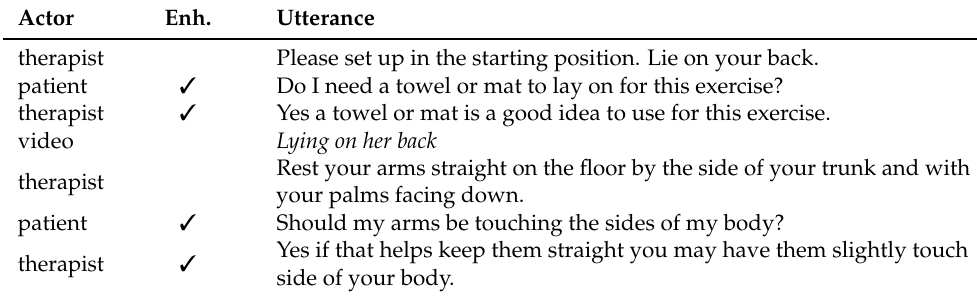
Table 1. Part of a dialogue collected in crowdsourcing. Enhancements added by workers are marked with (cid:51)